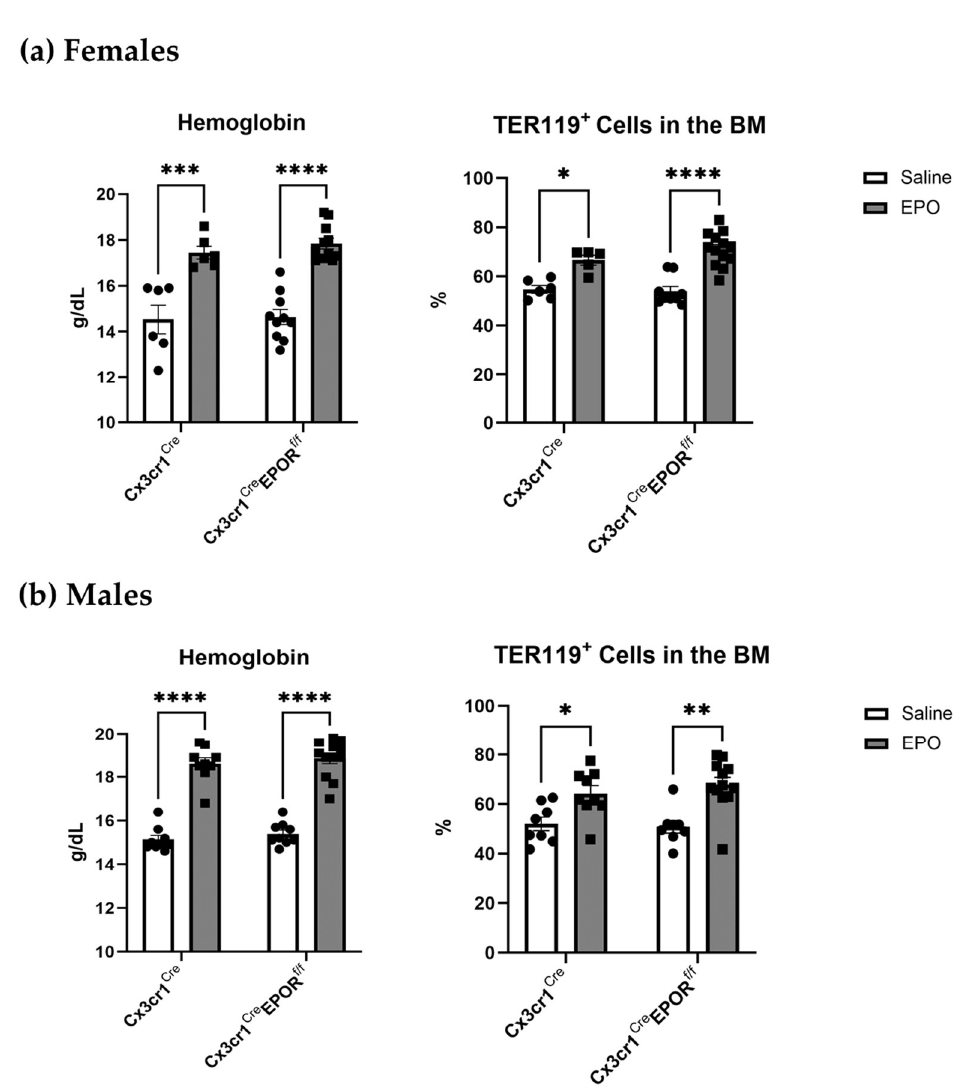
Figure 3. EPOR knockout in the monocytic lineage does not interfere with the erythropoietic response to EPO. Left panels, hemoglobin levels in Cx3cr1 Cre EPOR f/f as compared to their Cx3cr1 Cre controls after treatment with EPO (60 IUx3 per week for 2 weeks). Right panels, flow cytometry analysis of TER119 + erythroid progenitors in the bone marrow. ( a ) Females, ( b ) males. n = 6–12 mice in each group. * p < 0.05, ** p < 0.01, *** p < 0.001, and **** p < 0.0001. All data are mean ± SEM. p values were calculated by 2-way ANOVA.